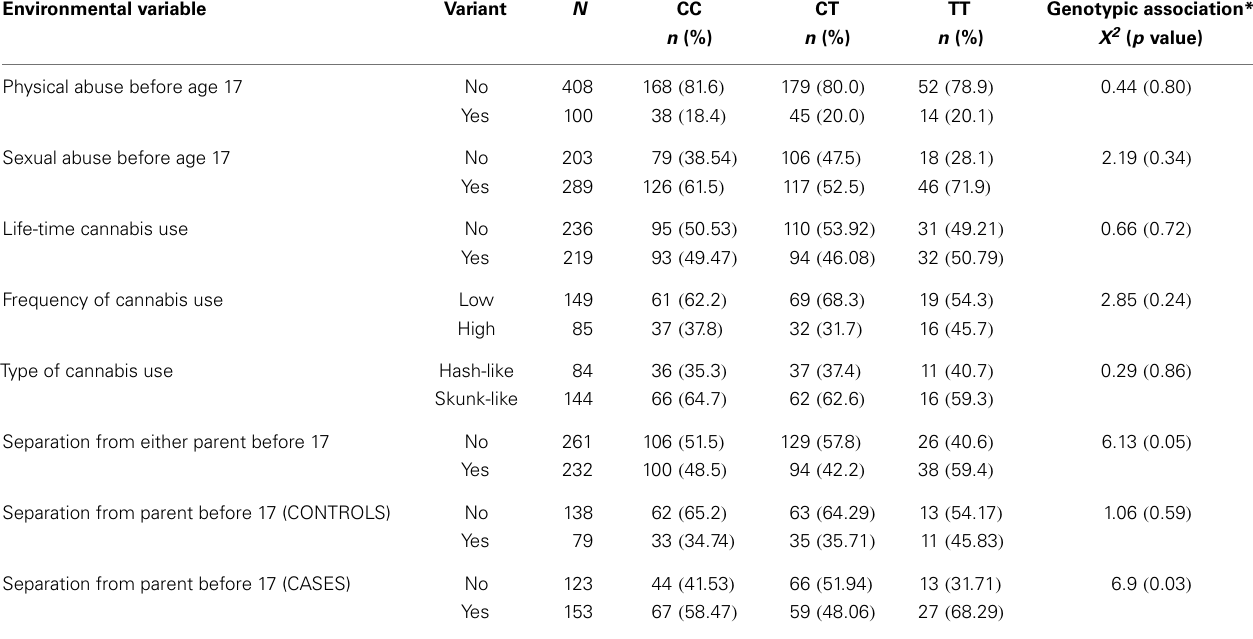
Table 2 |Association between environmental risk factors and FKBP5 genotype .